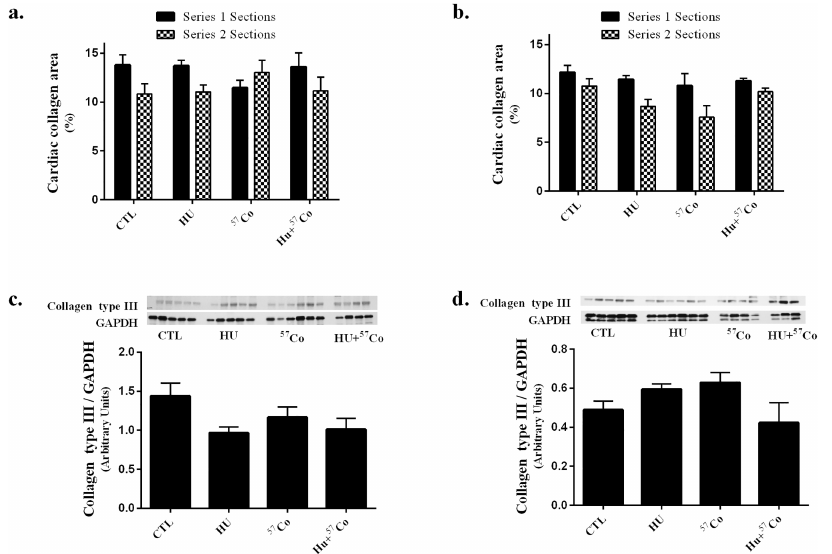
Fig 3. Collagen deposition in mouse heart following HU, γ irradiation or combined HU + γ irradiation. Sirius Red + Fast Green histological staining for total collagena.) 4 months and b.) 9 months after treatment. Two series of sections were obtainedfrom each heart, with the second series of histologysamplessectioned approximately 50 μ m deeperinto the heart. Statistical analysiswas performed by one-wayANOVA and repeatedmeasuresANOVA. Histologysample sizes: CTL for 4 month time-pointn = 4; CTL for 9 month time- point n = 5; HU for 4 month time-point n = 5, HU for 9 month time-point n = 6; 57 Co for 4 month time-point n = 5; 57 Co for 9 month time-point n = 5; HU+ 57 Co for 4 month time-point n = 3, HU+ 57 Co for 9 month time-point n = 5. Values are means ± SEM. Immunoblotanalysisof collagentype III protein content c.) 4 months and d.) 9 months followingHU, γ irradiationor combinedHU + γ irradiation. All proteins were normalized to GAPDH. Immunoblotting sample sizes: CTL for 4 month time-point n = 4; CTL for 9 month time-point n = 5; HU for 4 month time-pointn = 5, HU for 9 month time-point n = 6; 57 Co for 4 month time-point n = 6; 57 Co for 9 month time-point n = 4; HU+ 57 Co for 4 month time-point n = 4, HU+ 57 Co for 9 month time-point n = 3. Values are means ± SEM. Statistical analysisdid not revealany